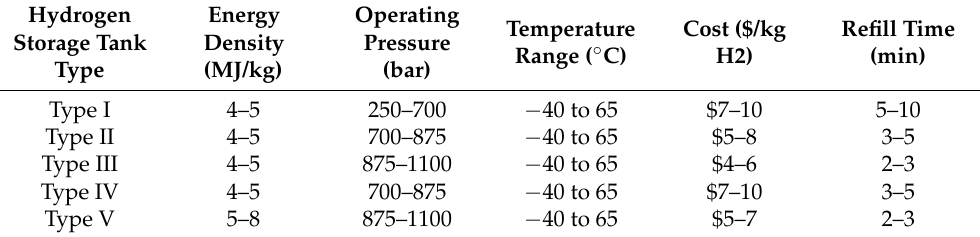
Table 1. Characteristics of different types of hydrogen storage